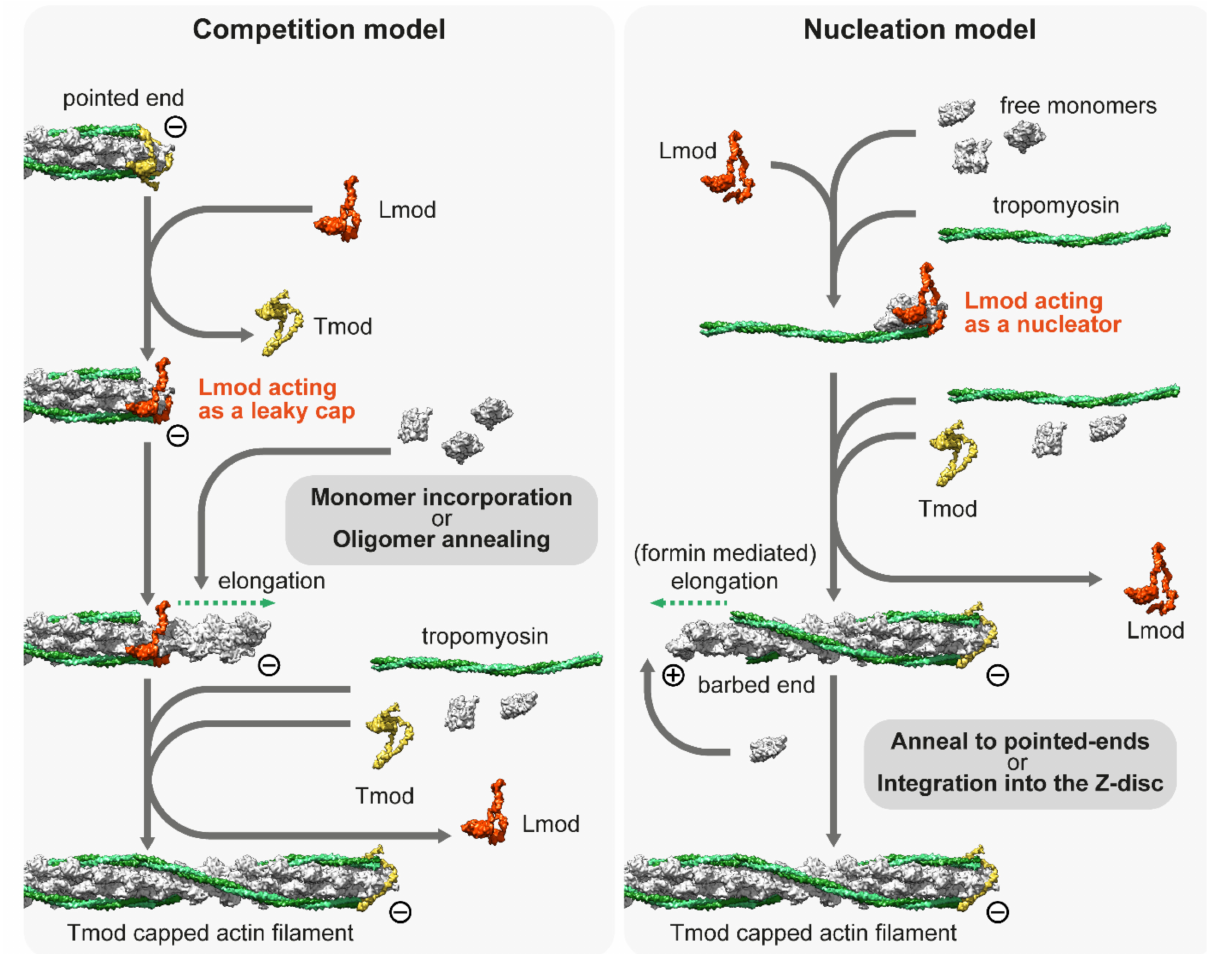
Figure 3. The competition and nucleation models of Leiomodin (Lmod). The competition model suggests that Lmod competes with Tmod, and once it is bound to the pointed end, it acts as a leaky cap, allowing the addition of monomers or short oligomers to the pointed end. The nucleation model suggests that Lmod is not able to bind to the pointed end but can act as a nucleation factor by binding at least three actin monomers and a tropomyosin dimer. The model proposes that Lmod dissociates from the actin nucleus when it begins to elongate, which can be mediated by formins. The newly formed filament can be incorporated into the Z-disc or annealed to free pointed ends. Note that both models presume that free monomers are available. The molecular model of Lmod is based on the tentative structure proposed by Tolkatchev et al.